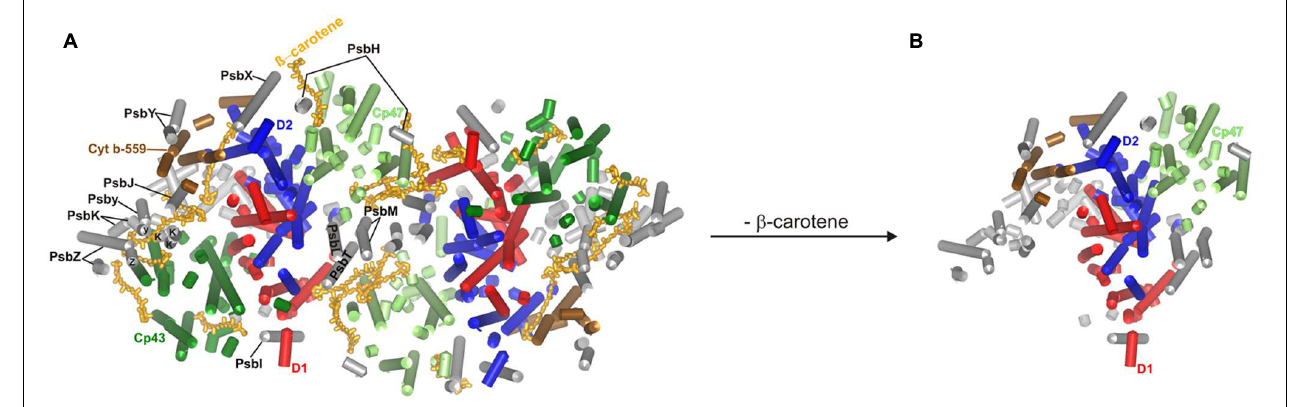
FIGURE 1 | Structure of the PSII complex deduced from X-ray crystallographic data (PDB files: 3BZ1 and 3BZ2). The PSII supercomplex in wild type (A) and assumed PSII structure in carotenoid-deficient (B) Thermosynechococcus elongatus